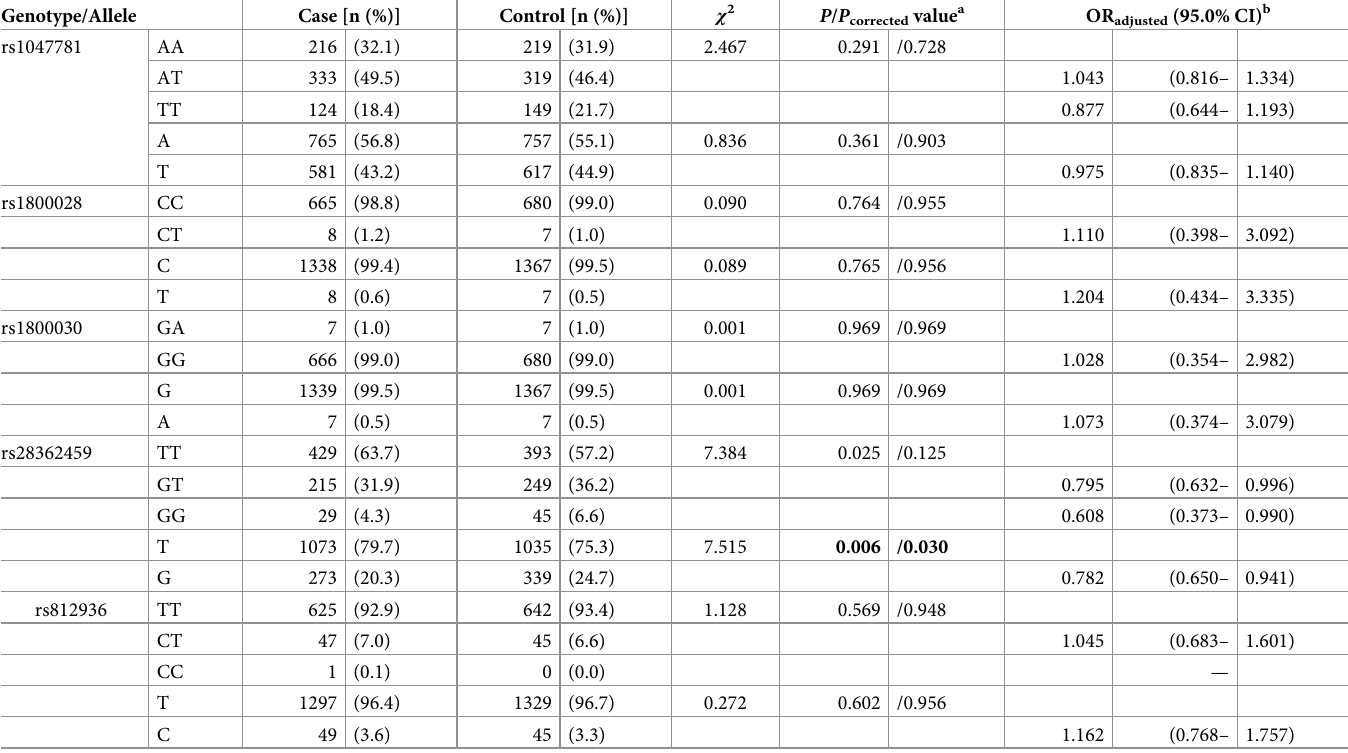
Table 2. Comparisons of genotype/allele frequency between cases and controls in the total participants. Genotype/Allele